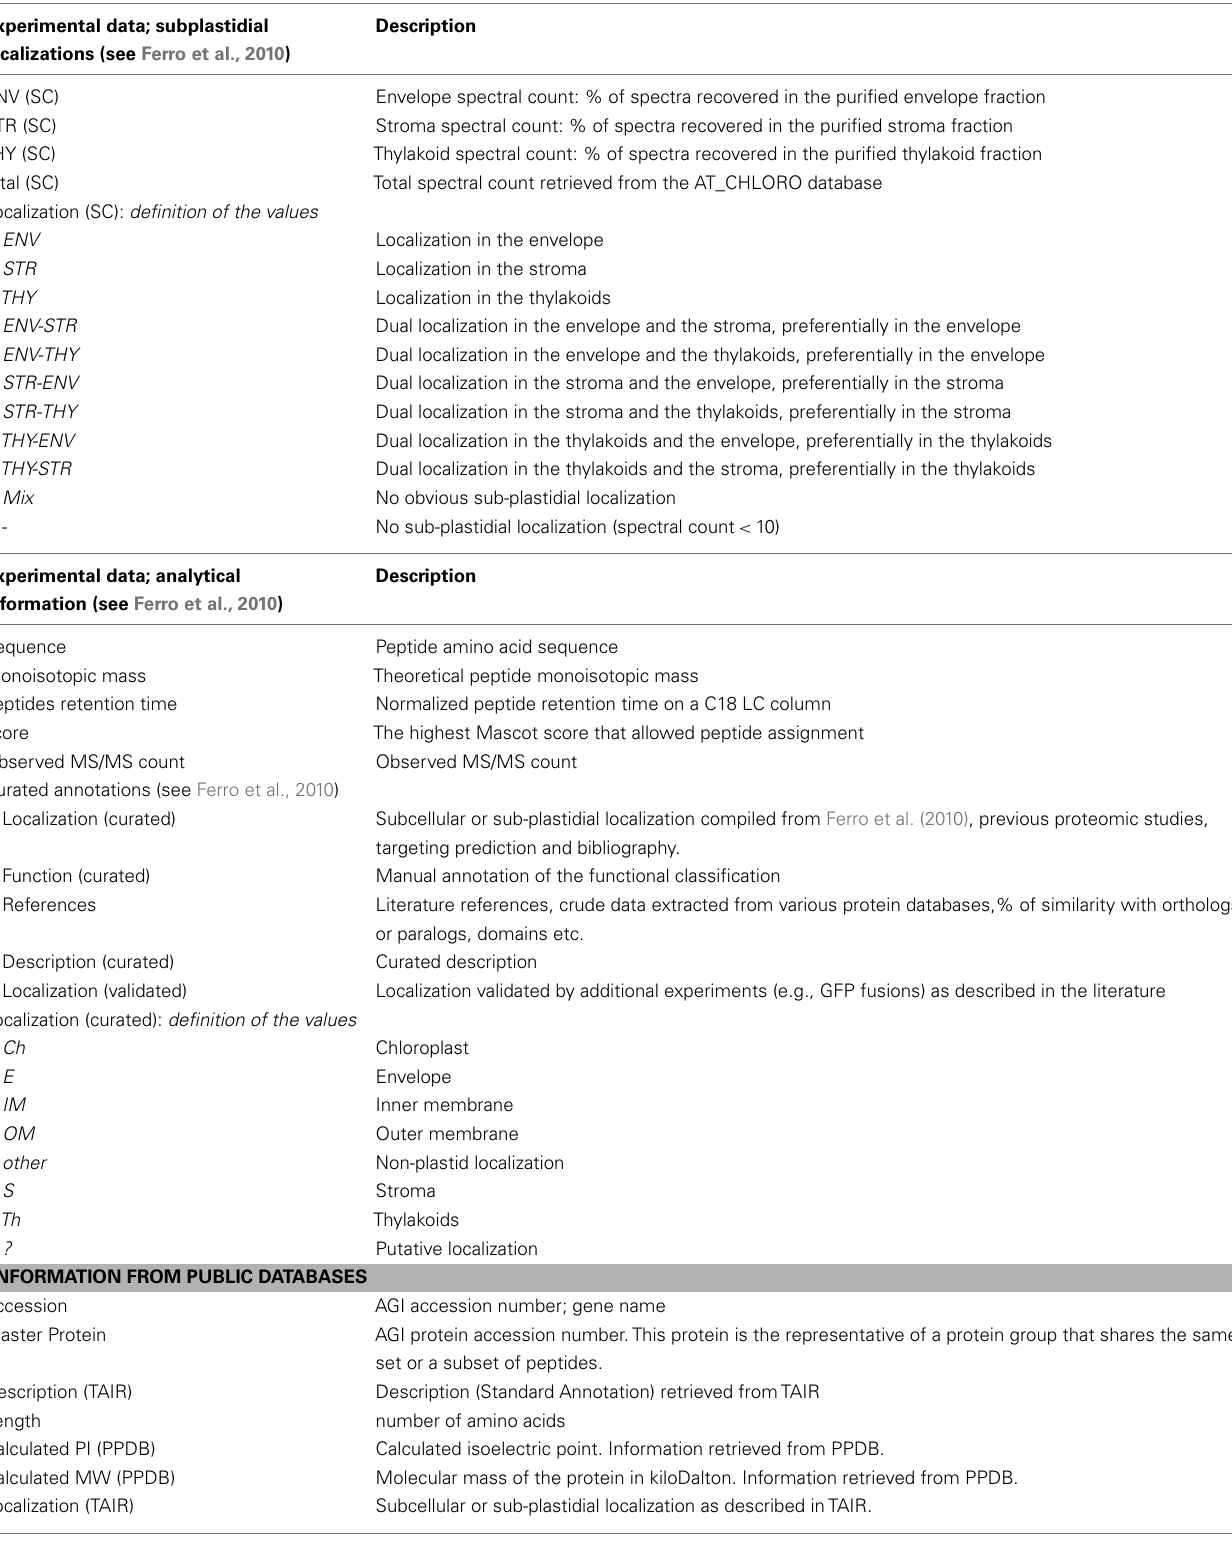
Table 1 | Description of the features found